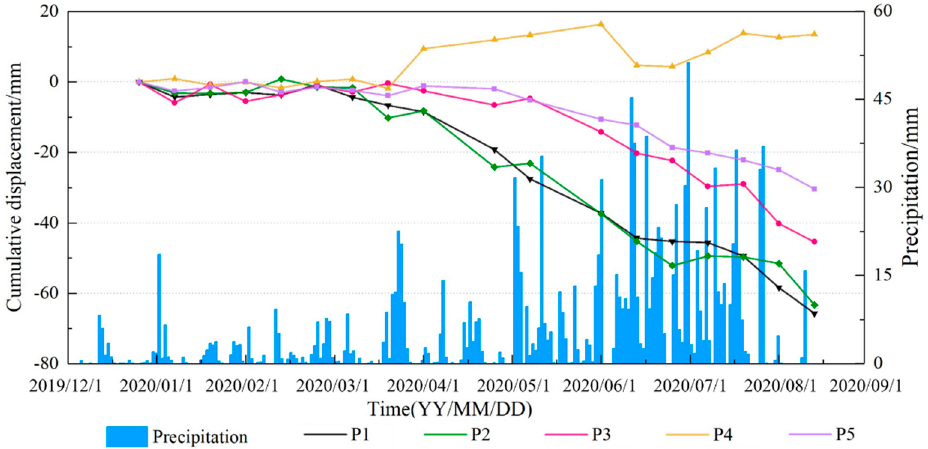
Figure 13. Mean velocities registered by the Sentinel-1A satellite.